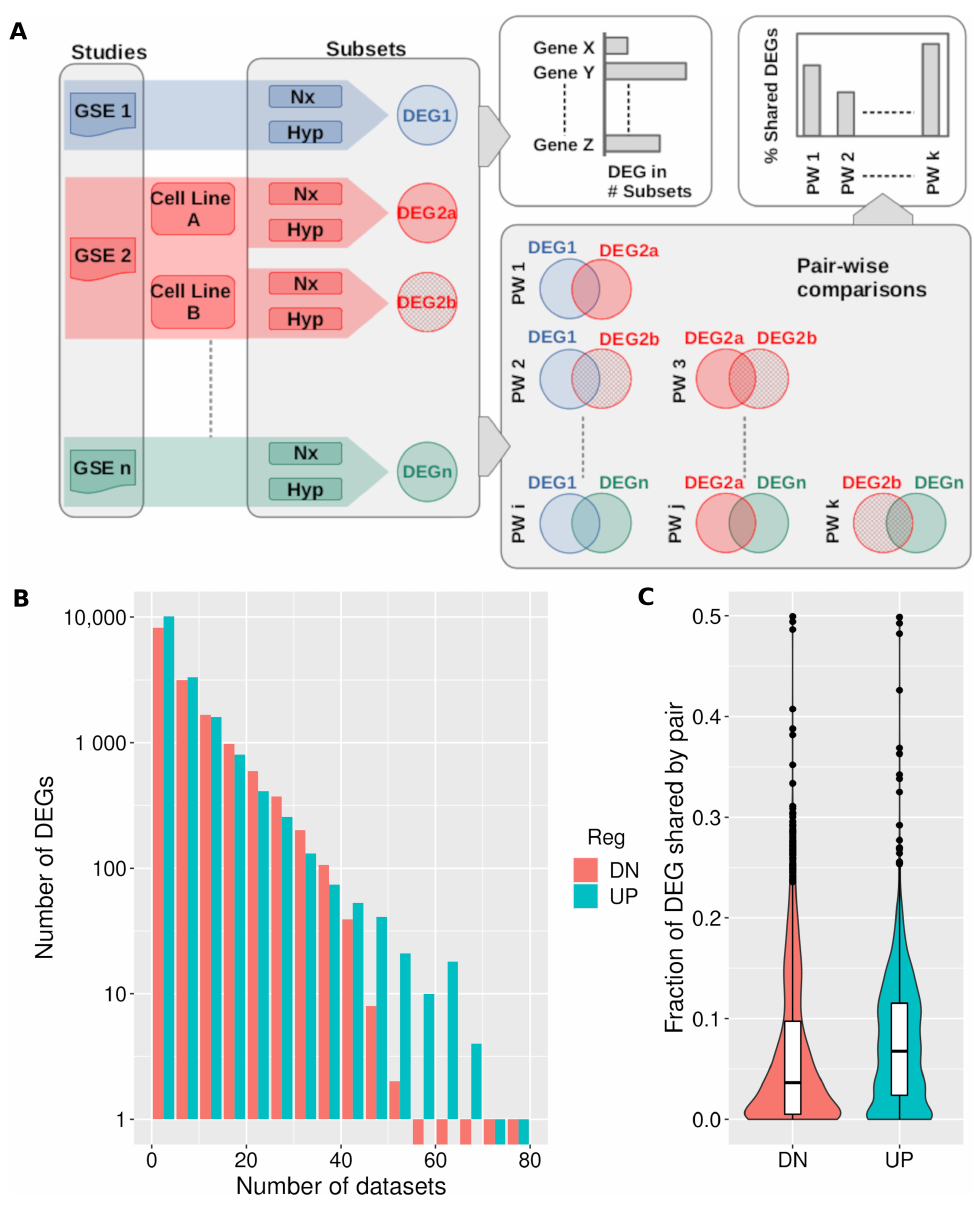
Figure 1. Hypoxic transcriptomes show limited overlap. ( A ) Diagram depicting the process used to compare hypoxic transcriptomes. Normoxic (Nx samples) and hypoxic (Hyp samples) replicates from the relevant studies (“GSE1”, “GSE2”, ...“GSEn”) were processed to identify genes whose expression was significantly affected by hypoxia (Differentially Expressed Genes, “DEGs”). In those studies analyzing more than a single cell line, time of exposure to hypoxia, or oxygen tension, samples were grouped to generate homogeneous subsets and the effect of hypoxia on gene expression was analyzed in each individual subset. The figure represents this situation in the case of GSE2 (shaded in red color), an hypothetical study that analyzed the effect of hypoxia in two different cell types. The number of datasets were a gene was found to be a DEG was recorded (see panel B). In addition, pairwise comparisons (“PW1”, “PW2”, ...“PWk”) between the 81 individual lists of DEGs were performed (lower right) to calculate the fraction of shared DEGs by each pair (see panel C). ( B ) Histogram showing the distribution of the number of down- (“DN”) or up-regulated (“UP”) genes binned by the number of datasets were the gene was found to be significantly regulated. In order to show the whole range, the y-axis is log10 scale. ( C ) Violin and overlaid boxplot showing the distribution of the fraction of down- (“DN”) or up-regulated (“UP”) genes shared in all 3240 possible pair-wise comparisons of the 81 datasets. For each pair of datasets A and B fraction of shared DEG was calculated as | A ∩ B | | A ∪ B |